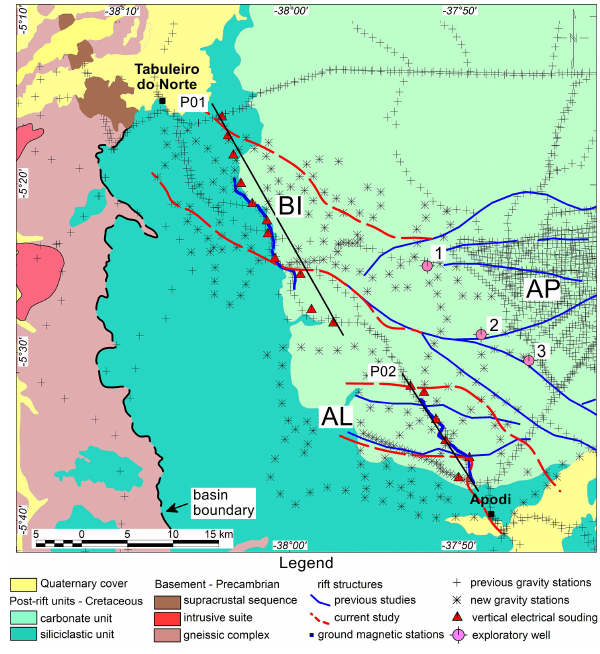
Figure 3. Geologic map of the SW border of the Potiguar rift with the location of the geophysical data sets. (Grabens: BI – Bica; AP – Apodi; and AL – Algodões. Profiles: P01 and P02 (black lines). Exploratory wells: 1, 2, and